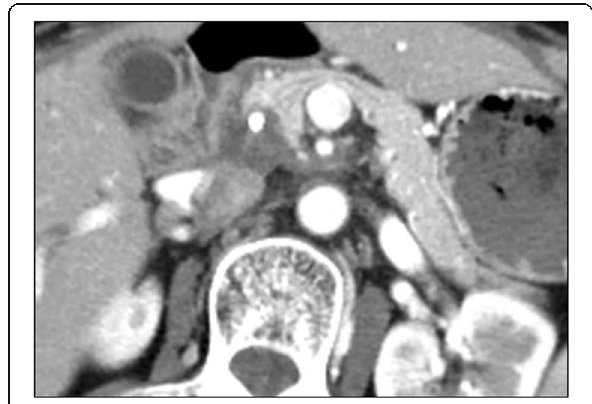
Fig. 3 The primary tumor shrank further after CIRT, and it was difficult to evaluate if viable tumor cells were present around the SMA from the MDCT images